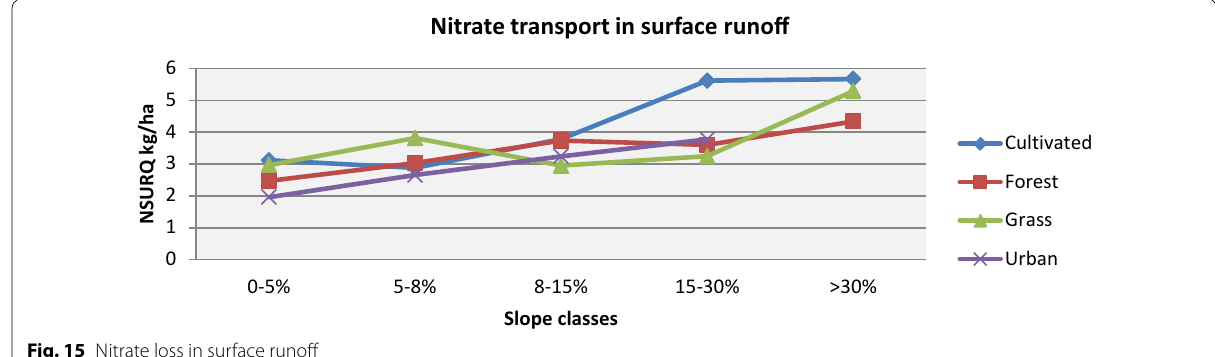
Fig. 15 Nitrate loss in surface runoff